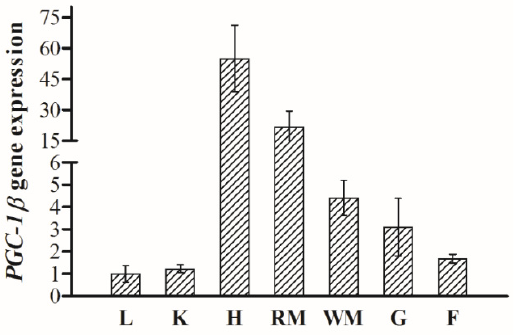
Figure 3. Expression of PGC-1 β gene in different tissues of blunt snout bream ( M. amblycephala ) (N = 6) (L, liver; K, kidney; F, fat tissue; RM, red muscle; WM, white muscle; H., heart; G, gill).